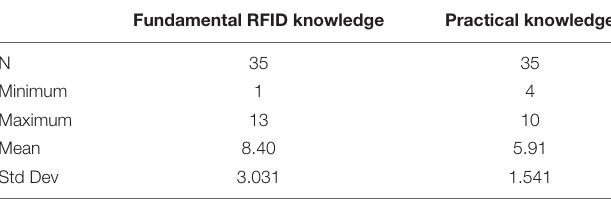
TABLE 4 | Post-test measurements for learning